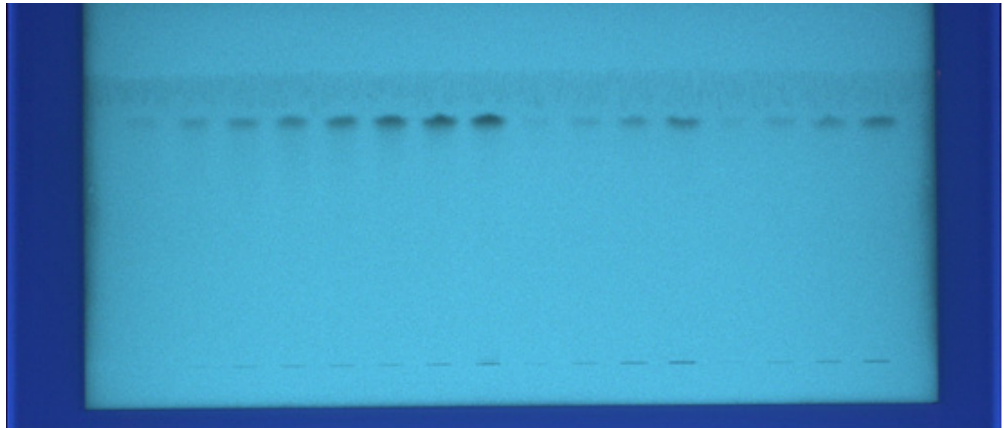
Figure 1. Pictorial diagram for the developed high-performance thin layer chromatography (HPTLC) plate of diosmin (DIOM).